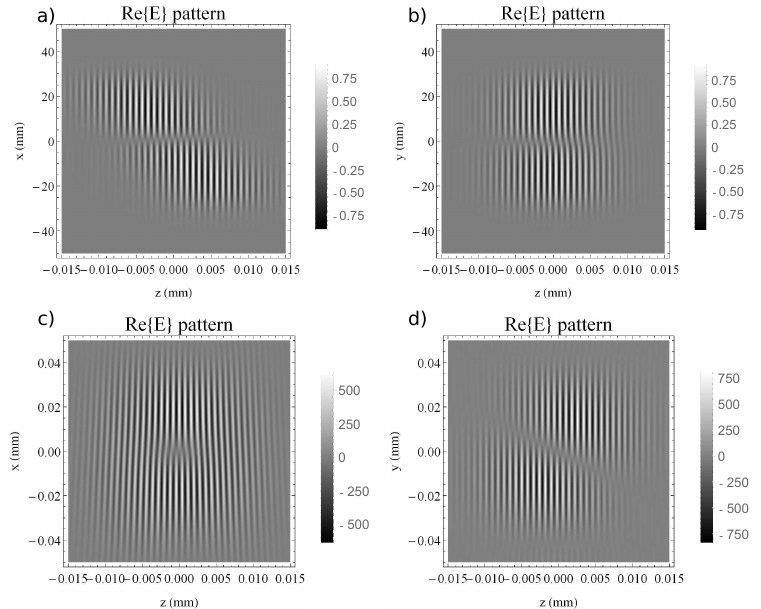
at t = 0) of the laser field with PFT = 0.8 fs/mm, E { } z for y = 0 and ( b ) on y z for x = 0; − − z for y = 0 and ( d ) on y z for x = 0. For simplicity, − −